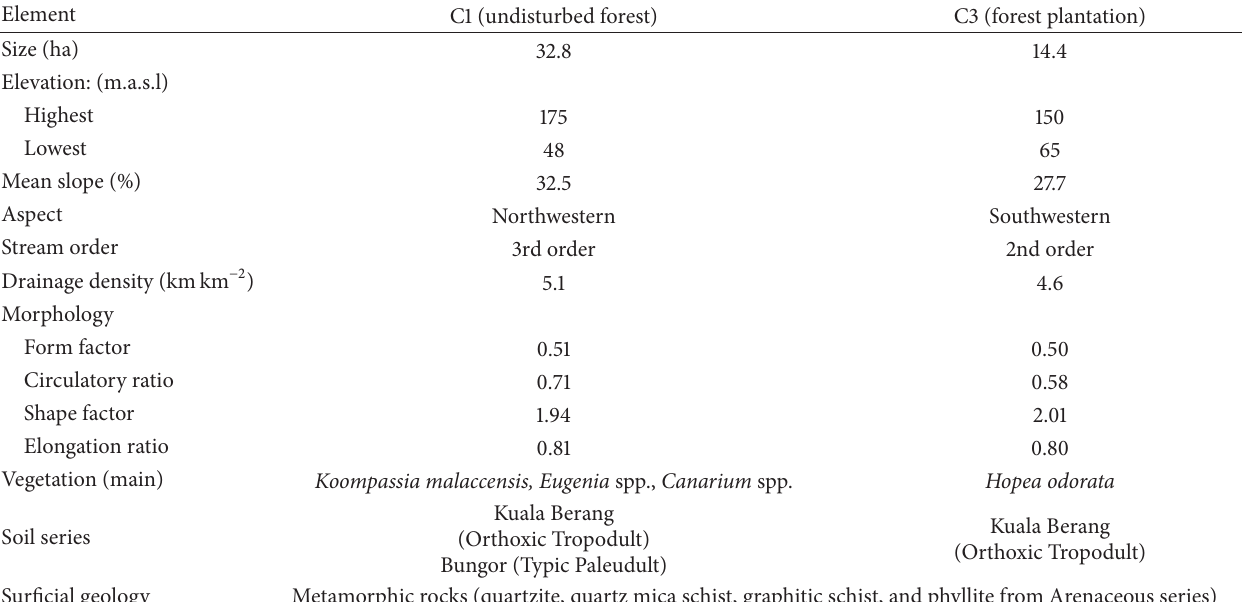
Table 1: Catchment characteristics of C1 and